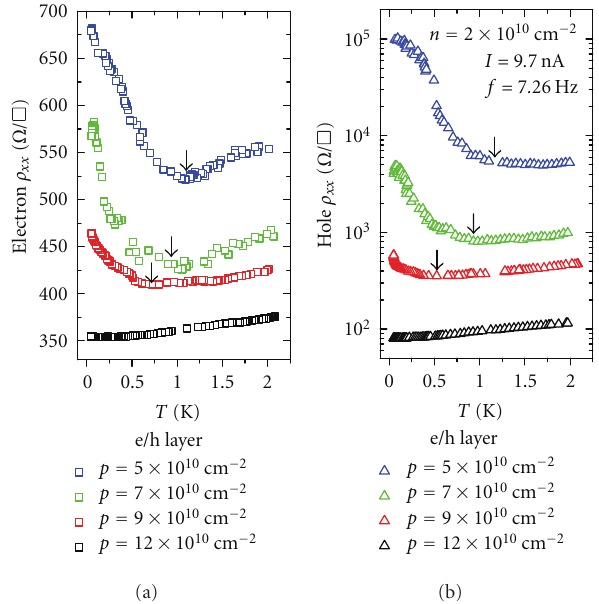
Figure 22: Resistivity of electron (a) and hole (b) layers versus temperature, for constant electron density ( n = 2 × 10 10 cm − 2 ) and di ff erent hole densities ( p = 5,7,9,12 × 10 10 cm − 2 ). Arrows indicate approximate points of transition to insulating behaviour. (Device: B138/C4-2-10nm